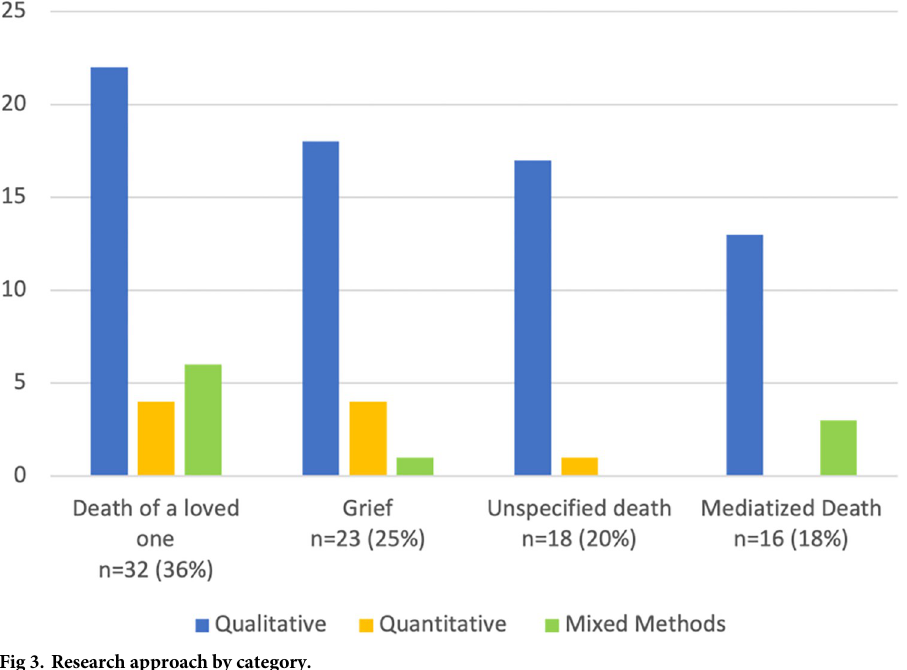
Fig 3. Research approach by